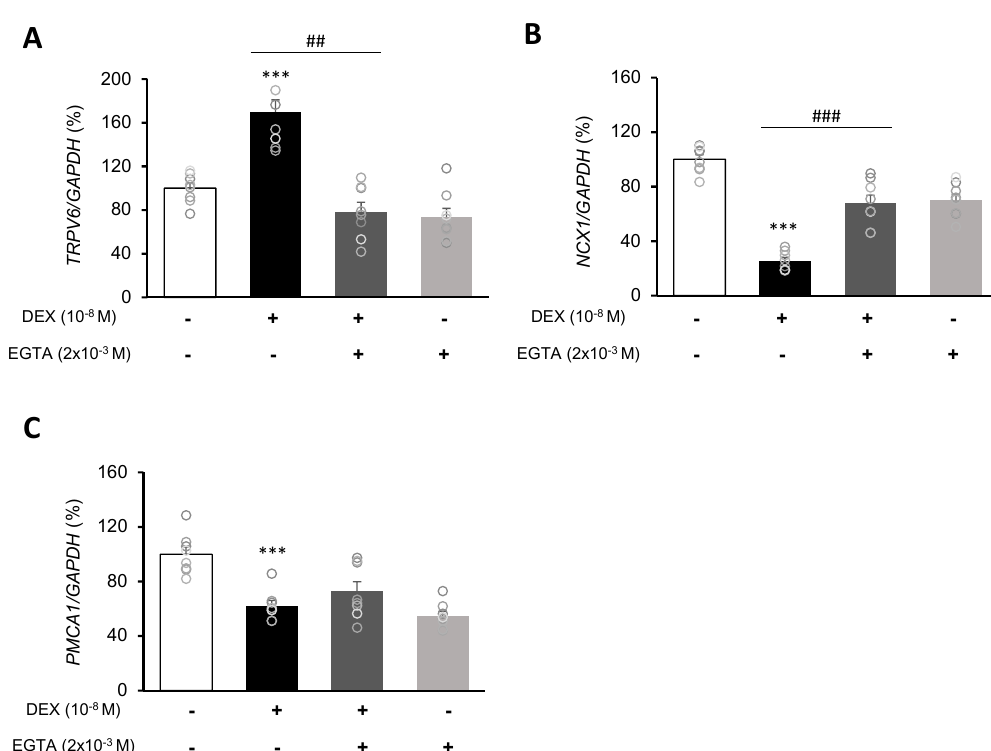
Figure 4. Effect of EGTA on calcium-processing genes in A549 cells. Effect of EGTA and DEX on the transcriptional level of ( A ) transient receptor potential cation channel subfamily V member 6 (TRPV6), ( B ) sodium-calcium exchanger (NCX1), and ( C ) plasma membrane calcium ATPase 1 (PMCA1) by real-time PCR. The mRNA level was measured by performing real-time PCR and was normalized by GAPDH. *** p < 0.001 versus control; ## p < 0.01 versus EGTA; ### p < 0.001 versus EGTA.